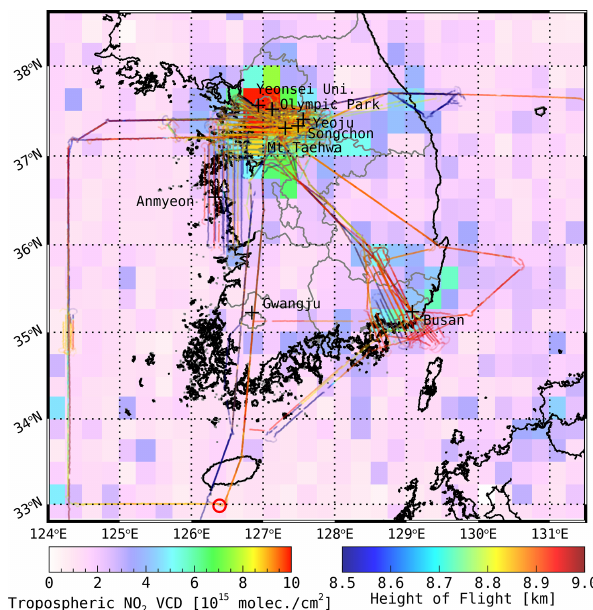
Figure 1. Flight paths of the NASA LaRC B200 aircraft carrying GeoTASO and the average tropospheric NO 2 VCDs obtained from OMI gridded to a 0.25 ◦ × 0.25 ◦ horizontal grid during the KORUS- AQ campaign period. The color of each line represents flight height. In this period, the GeoTASO observations focused on megacities (Seoul and Busan) and an industrial complex area (Anmyeon) with high tropospheric NO 2 concentrations. The reference spectrum for spectral fitting is obtained from the radiation data over Jeju Island (marked with a red